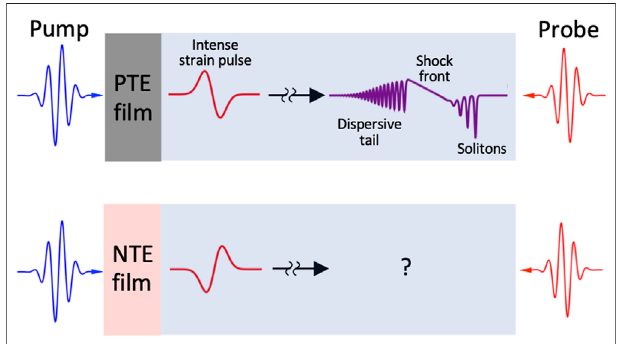
FIGURE 1 | (A) Schematic of PTE fi lm on substrate with laser pulse incident, then propagating strain pulse through PTE bulk sample, forming a shock front trailing a set of well-separated solitons. (B) Schematic of NTE fi lm on substrate with laser pulse incident, then propagating strain pulse through PTE bulk